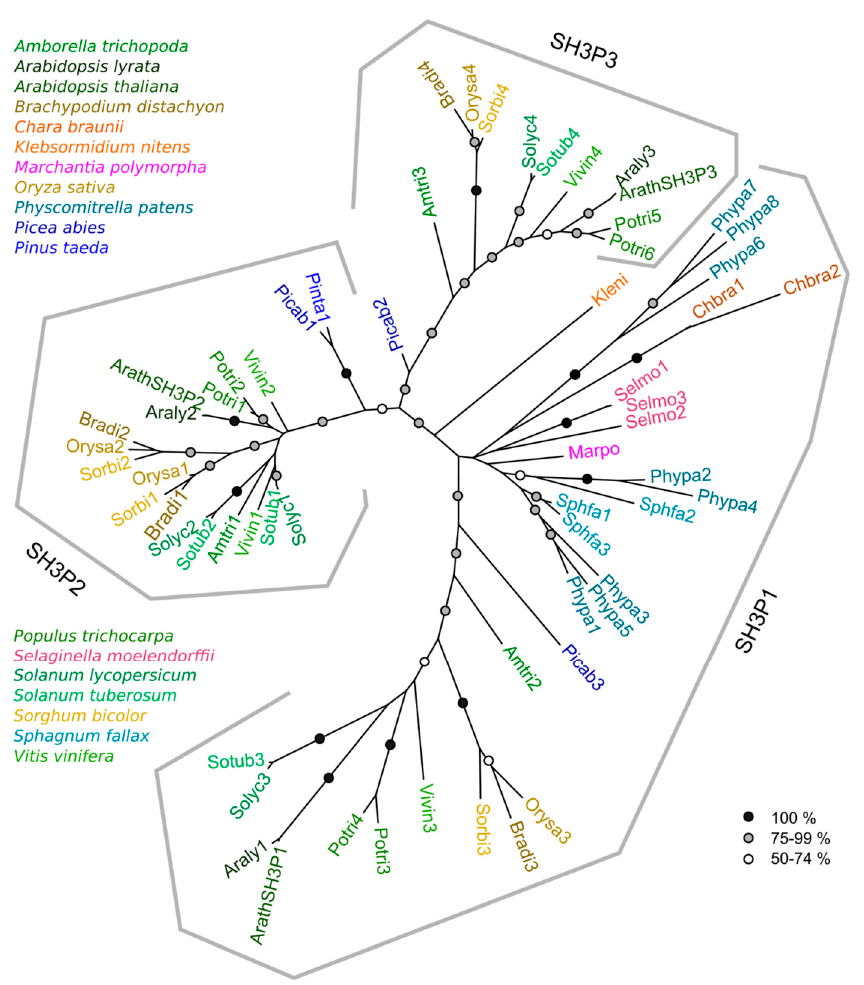
Figure 1. A maximum likelihood phylogenetic tree of plant SH3P protein sequences. Symbols at branches denote bootstrap support (no symbols for support below 50%). For accession numbers of all sequences, see Supplementary Table S1.